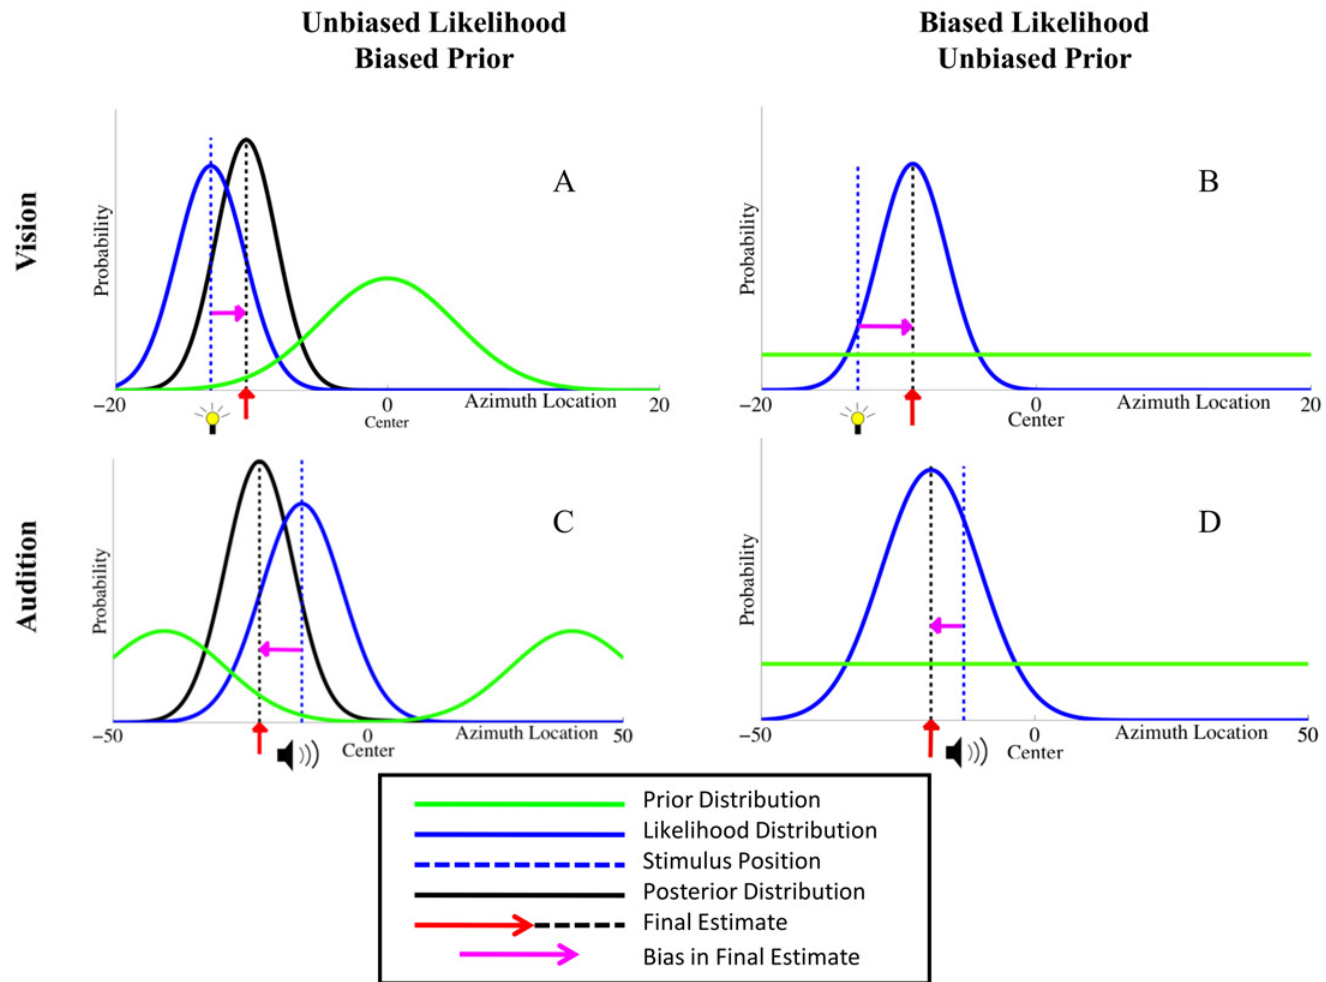
Fig 1. Possible underlying mechanisms for the biases observed in subjects ’ localization responses. Zero on the x-axis represents the center. In panels (B) and (D), the likelihood and posterior functions are overlapping and are shown in blue. In the visual domain, (A) a prior distribution located at the center of visual space could draw localization estimates towards the center, or (B) the likelihood distributions themselves could be biased, drawing sensory estimates towards a central location. In the auditory domain, (C) a prior bias for periphery could push perception of peripheral target estimates further away from the center of space, or (D) the likelihood distributions themselves maybe biased away from the center. Various combinations of these computational mechanisms were tested in the different proposed models (see Model Comparisons